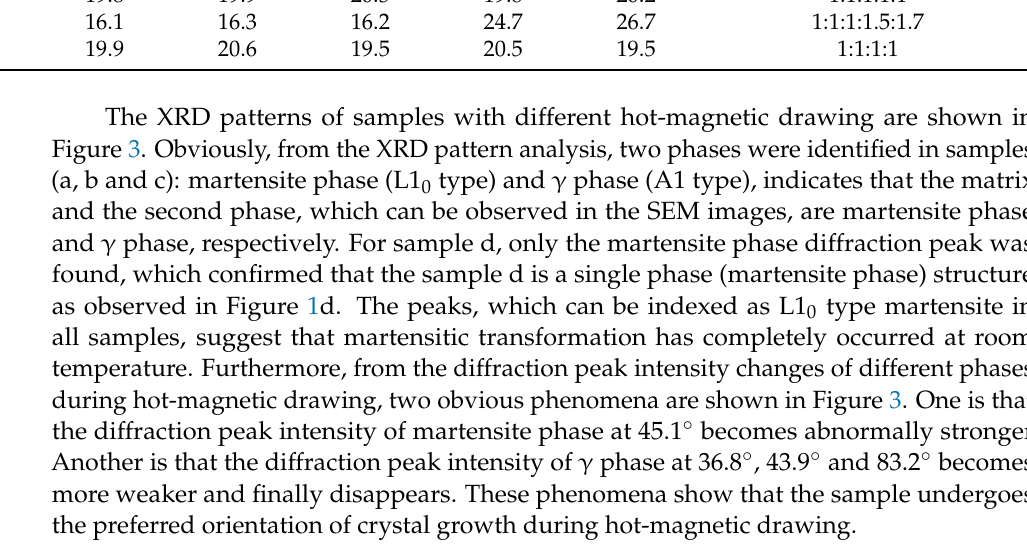
⑤ in Figure 2c, atomic ratio: Ni:Mn:Ga:Gd:Co ≈ 1:1:1:1:1), and the aggregation of Gd and Co is obviously weakening in the second phase (scan area ⑥ in Figure 2c, atomic ratio: